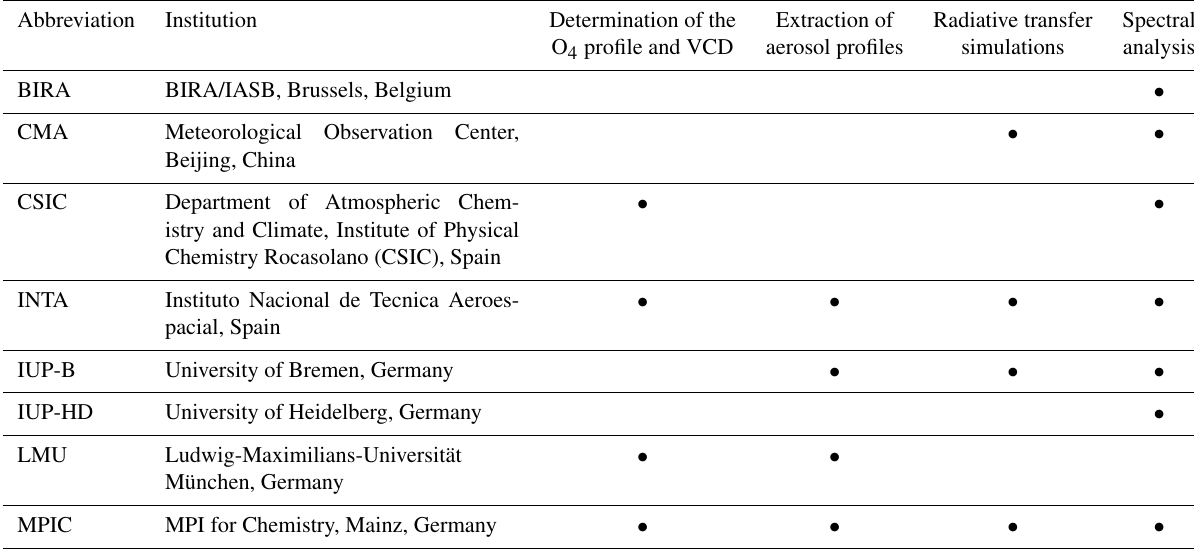
Table 3. Participation of the different groups in the different analysis steps. Abbreviation Institution Determination of the Extraction of Radiative transfer Spectral O 4 profile and